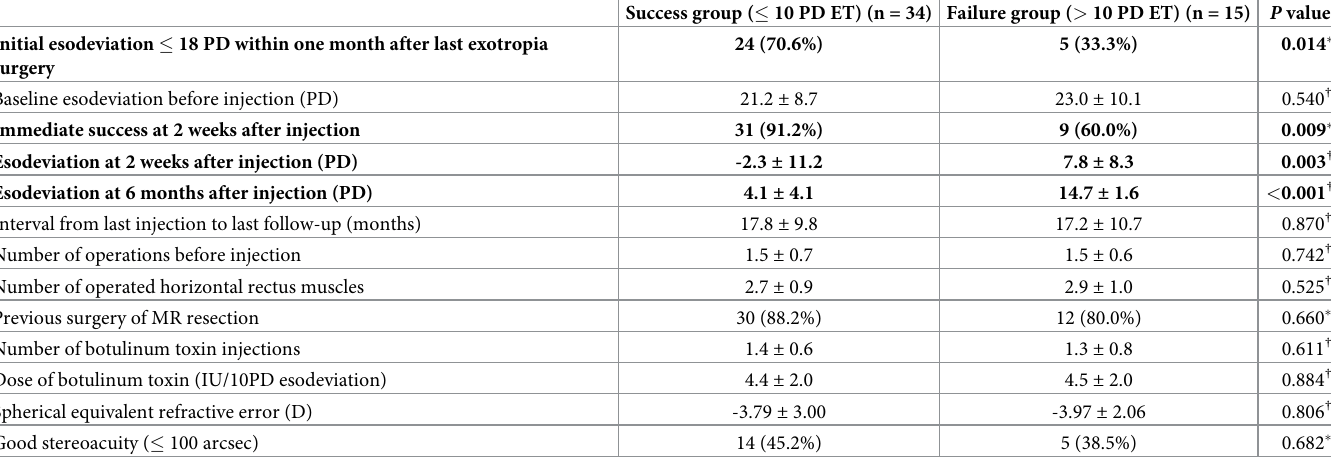
Table 2. Comparison of the success group and failure group at 6 months after last botulinum toxin